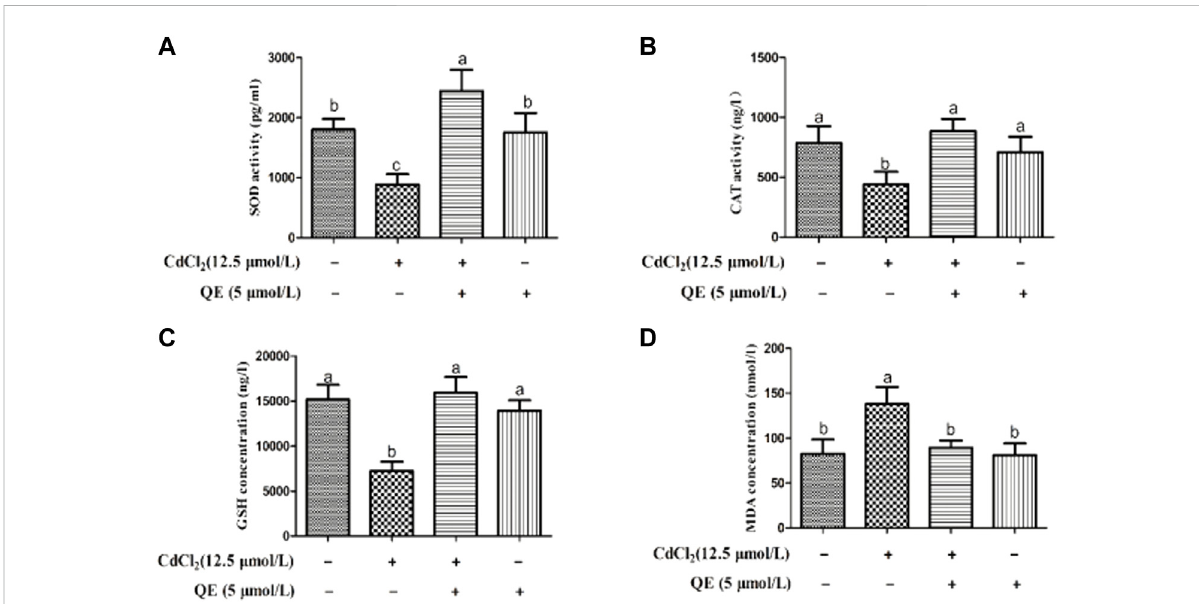
FIGURE 3 Effects of QE on cadmium-induced activities or contents of SOD, CAT, GSH, and MDA in BRL-3A cells. The SOD (A) and CAT (B) activities and theGSH (C) andMDA (D) concentrationsinthecellsupernatantweremeasured.Dataareexpressedasthemean±SEM.Datawithdifferentletters(a, b, and c) represent signi fi cant differences ( p < 0.05) among different